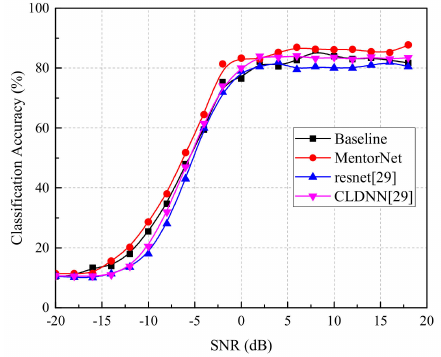
Figure 13. Classification accuracy of various classifiers on dataset